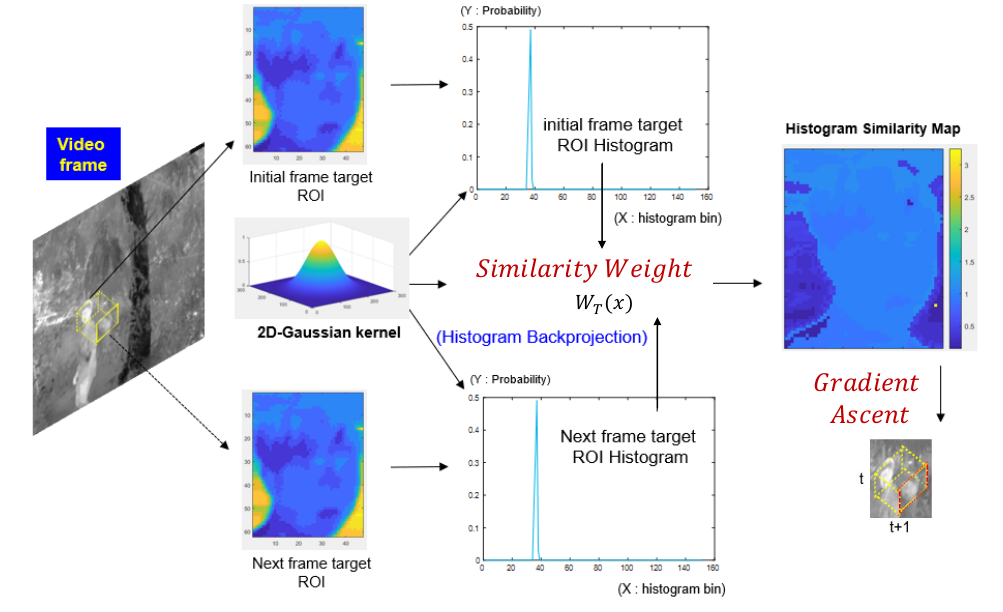
Figure 6. Overview of the TIR-MS